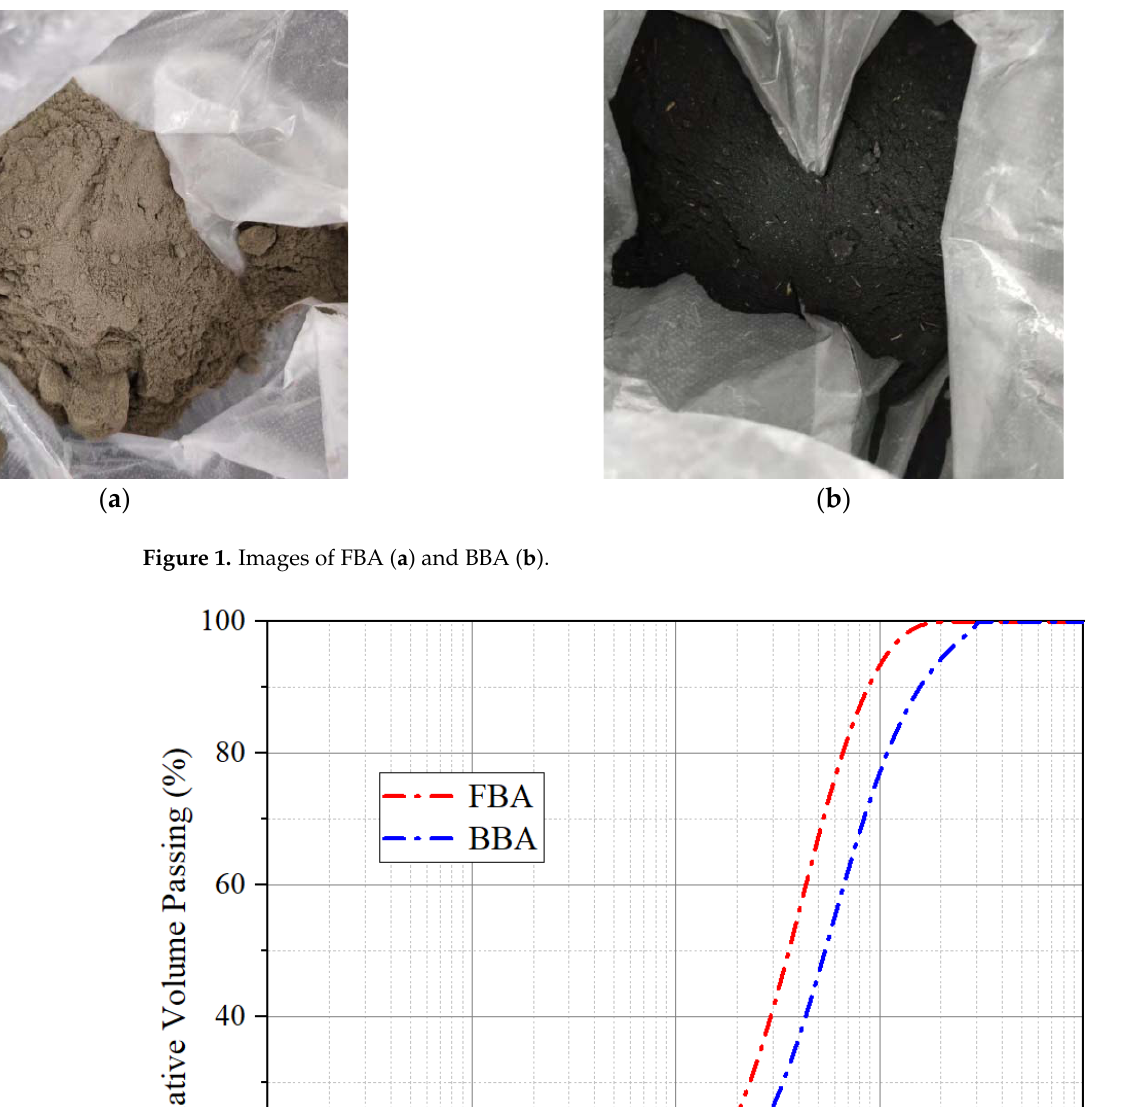
183 Figure 3. The pictures of specimens for different mix proportions.